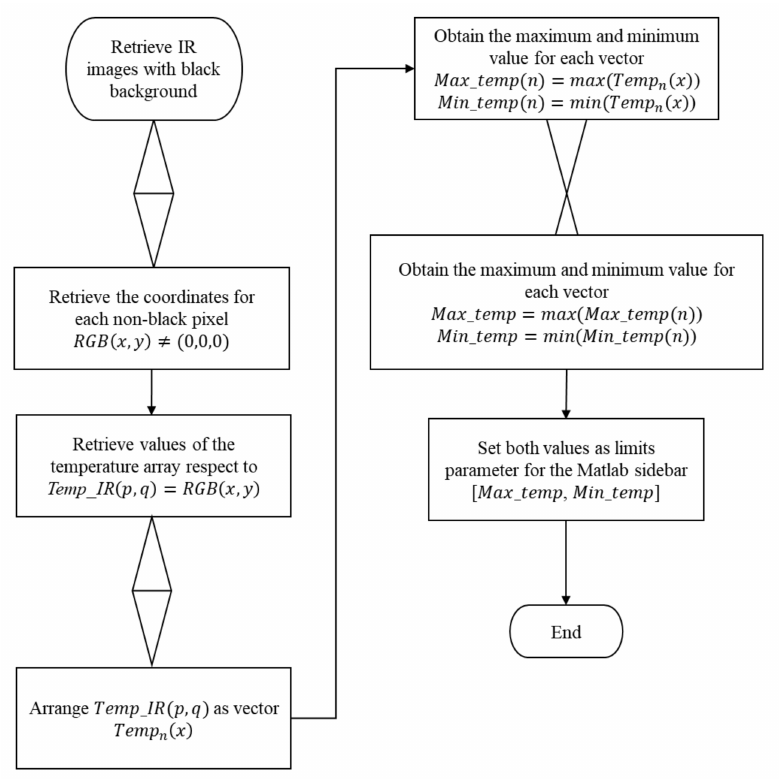
Figure 10. Flowchart for obtaining the limits of the color bar function for the temperature matrix